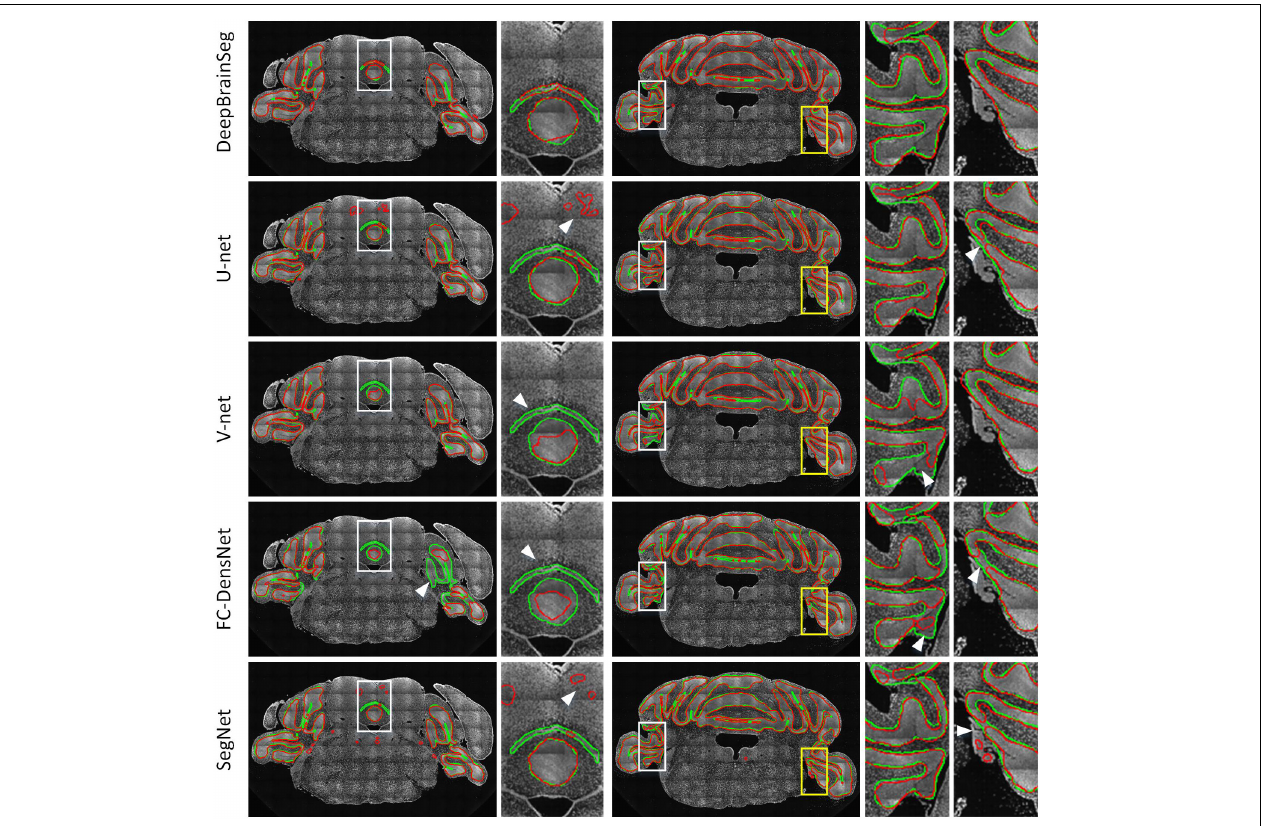
FIGURE 9 | Comparison among DeepBrainSeg, U-net, V-net, FC-DenseNet, and SegNet. From top to bottom, the five rows show the segmentation effects of these methods, respectively. The first and third images in each row are superpositions of coronal images and the segmented lines: the green lines are the ground truth and the red lines are the automatically segmented lines. The second, fourth, and fifth images show enlarged views of the areas in front white boxes. White arrows show the inaccurate segmentations.